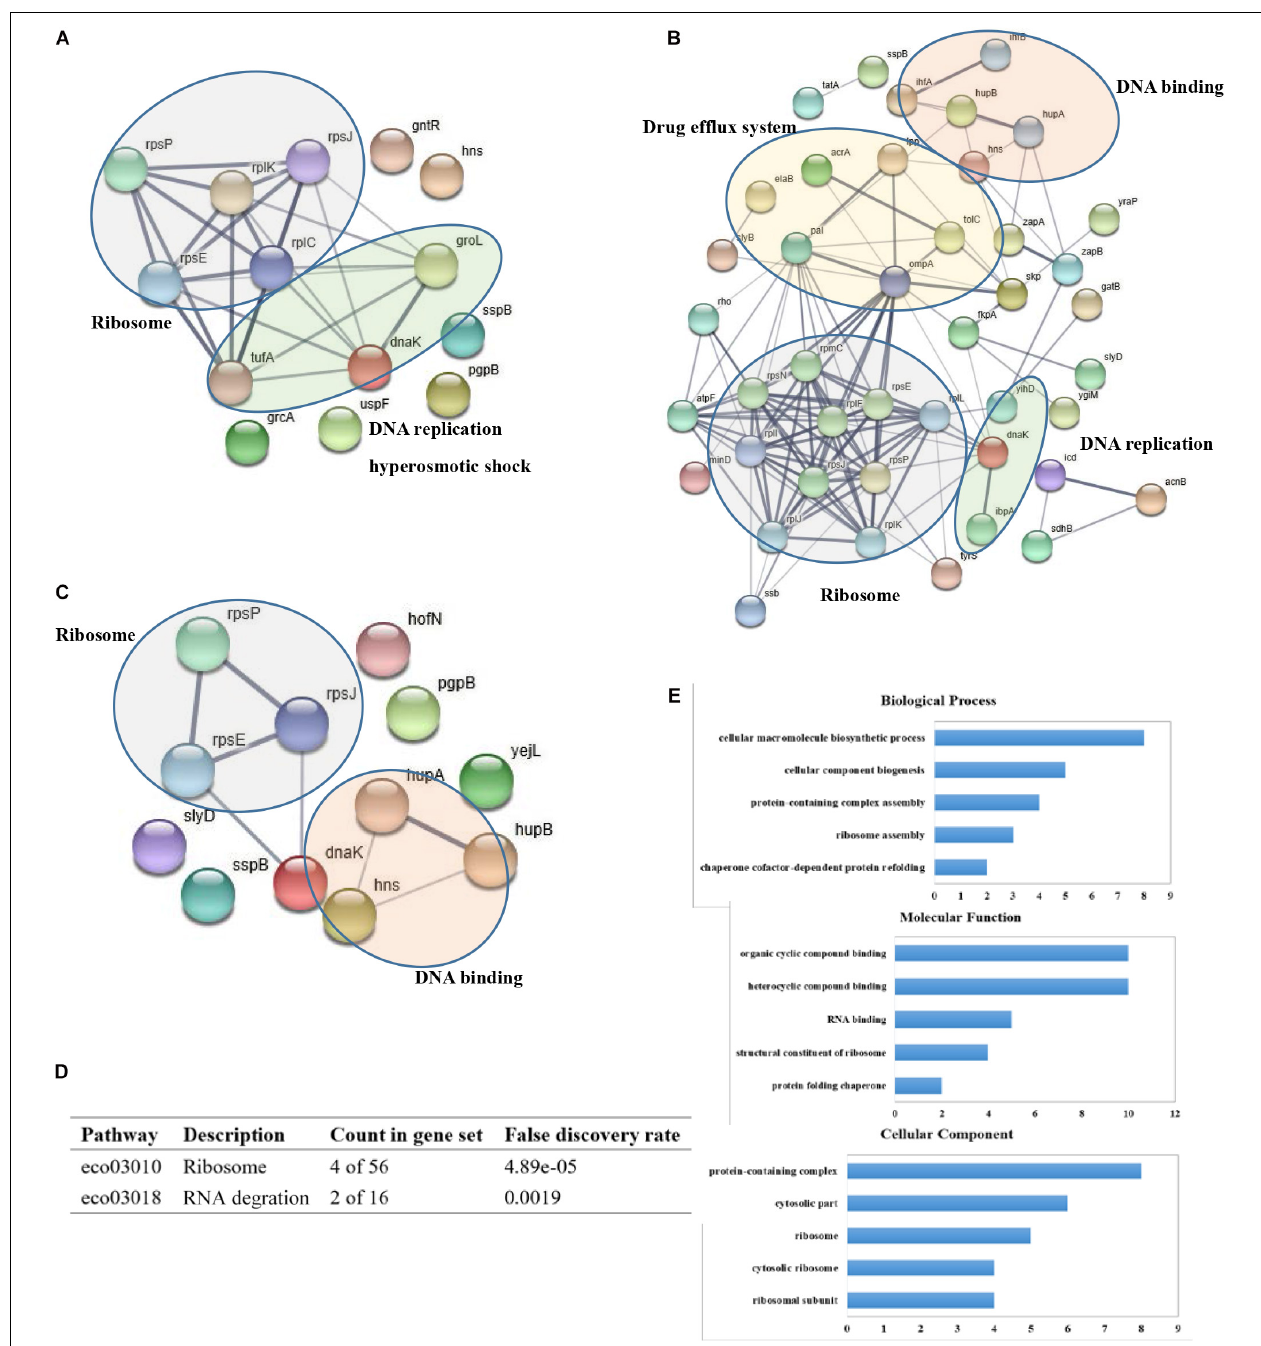
FIGURE 2 | Defining the MCR-1 functional interactome. (A) PPI network generated for 14 MCR-1 interactors using experimental evidence in STRING database and medium confidence links ( > 0.400) in E. coli DH5 α (pUC19- mcr-1 ). Thickness of edges represent strength of evidence supporting interaction; (B) PPI network generated for 53 MCR-1 interactors in E. coli BL21 (DE3) (pET28a- mcr-1 ); (C) PPI network of the 13 MCR-1 interactors in E. coli BL21 (DE3) (pET28a- mcr-1-200 ); (D) KEGG pathway analysis of the interacting proteins of MCR-1 in E. coli DH5 α (pUC19- mcr-1 ); (E) GO enrichment analysis of the interacting proteins of MCR-1 in E. coli DH5 α (pUC19- mcr-1